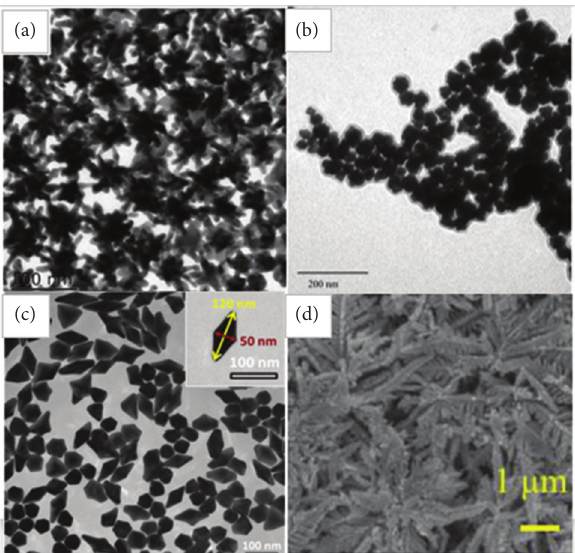
Figure 3: Scanning electron micrographs of (a) gold nanostars [57], (b) silver nanodendrites [58], (c) bipyramid gold nano- particles [59], and (d) flower-like gold nanoparticles